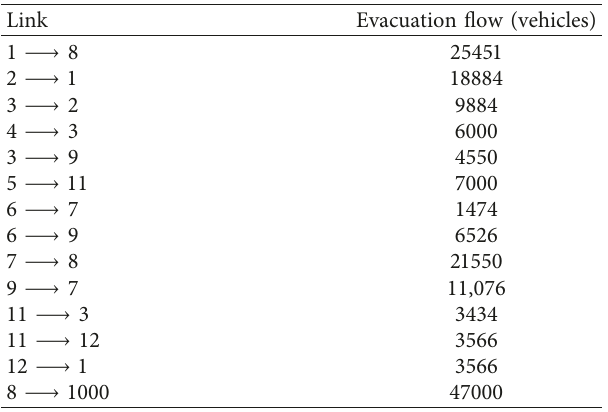
Table 4: Cost of shelter construction. Shelter node